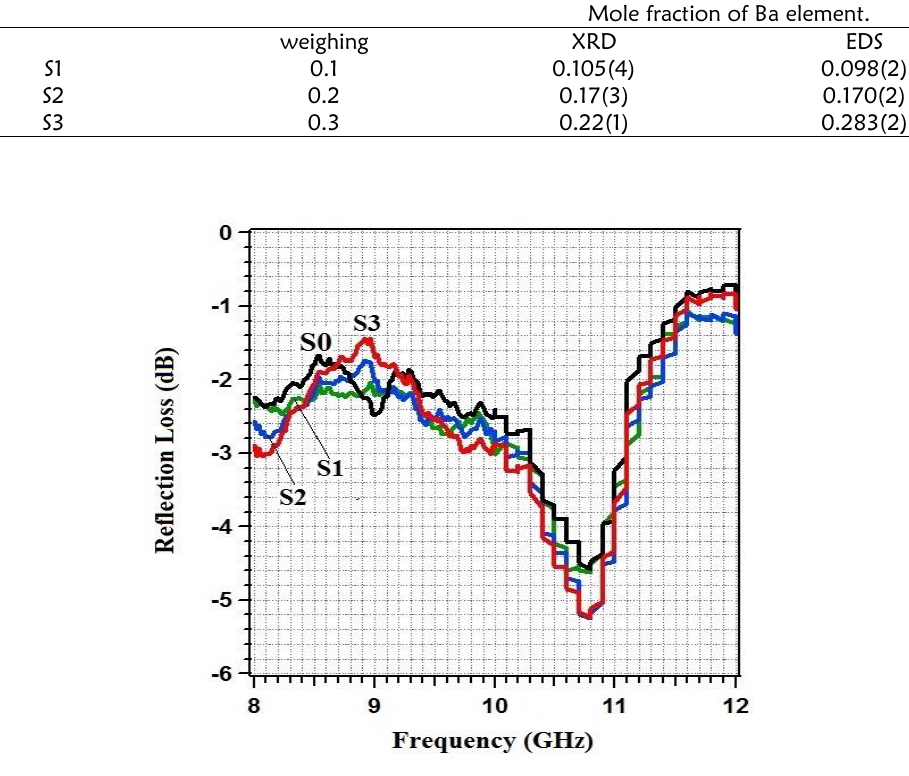
Figure 3. The microwave absorbing characteristics of the S0, S1, S2 and S3 samples in the range of 2-12 GHz.